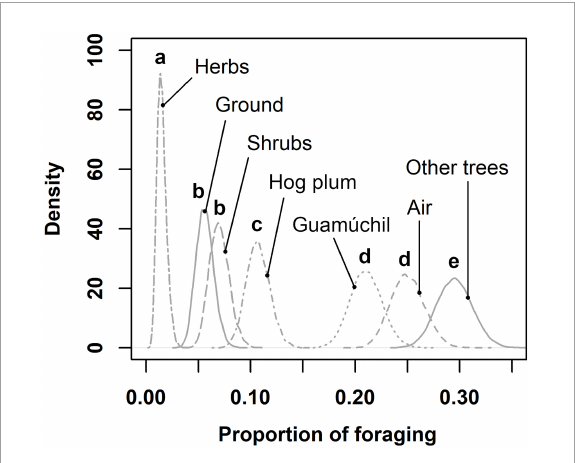
FIGURE2 Estimated proportion of bird foraging for different types of substrates in Zacualpan, Colima, Mexico. Letters above curves depict statistical differences among